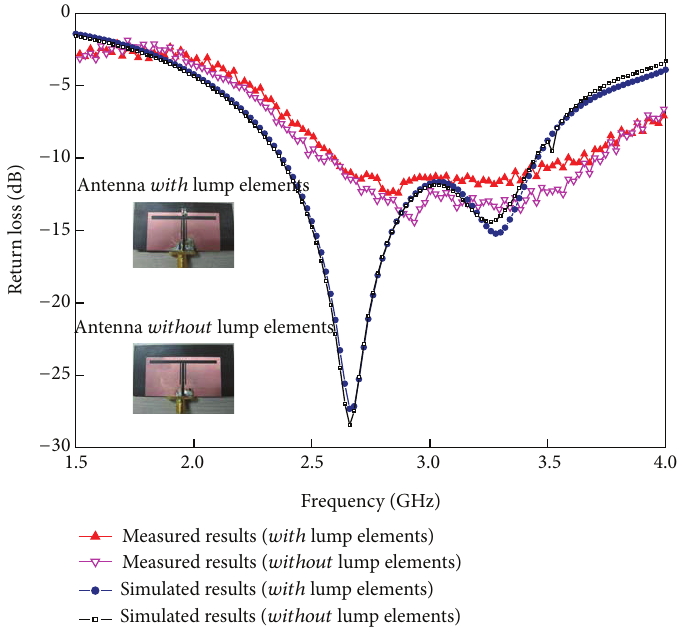
Figure 7: Return losses of antennas with and without lump